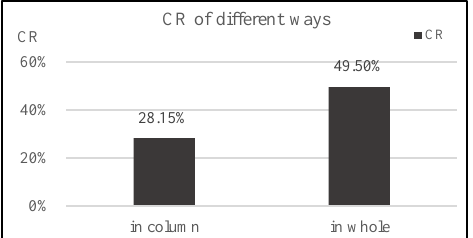
Fig. 6. Compression ratio of different ways